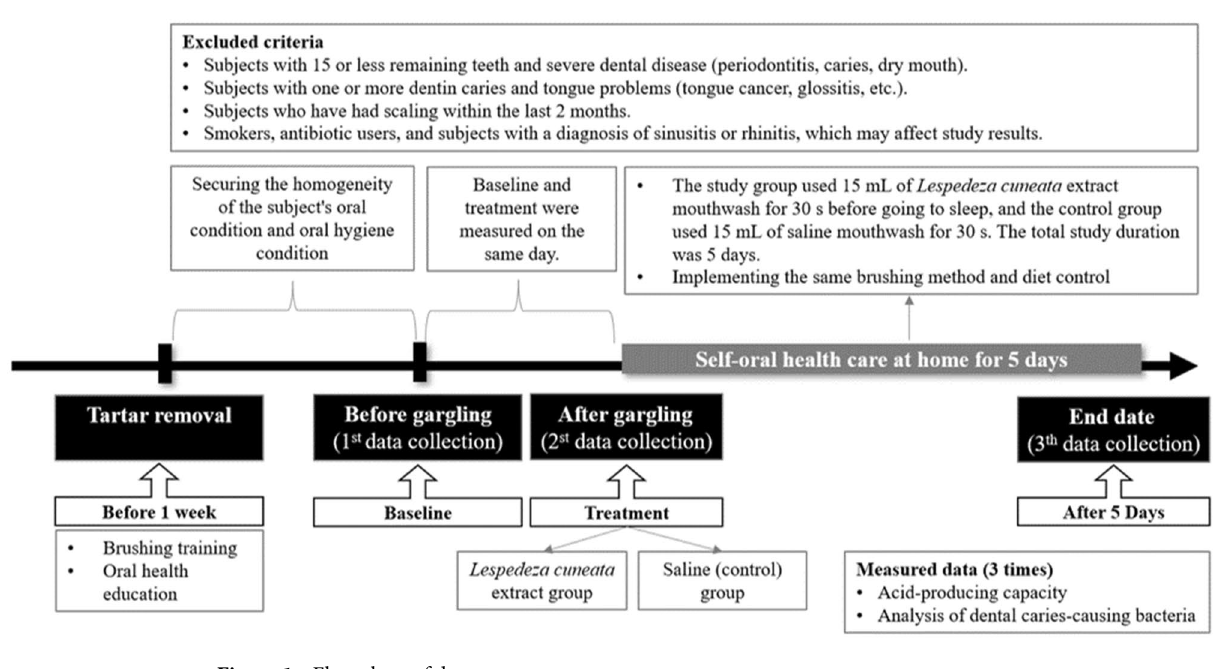
Figure 1. Flow chart of data measurement.